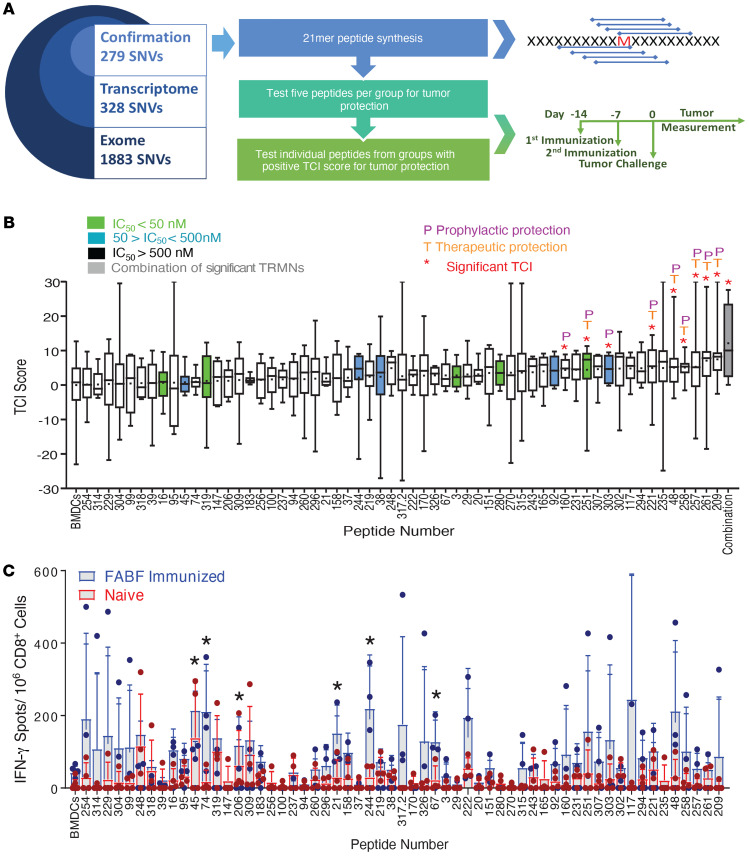
Unbiased identification of TRMNs.(A) All experimentally confirmed SNVs of the MC38-FABF tumor, and screening strategy for tumor rejection. (B) Box-and-whisker plot representing the tumor control index (TCI) scores (9) for 58 of all 279 peptides, represented by numbers on the x axis. The remaining 221 peptides elicited no tumor control and are not shown. The negative control (extreme left) consists of mice immunized with unpulsed BMDCs. Peptides that elicited significant tumor control are marked by asterisks. P and T indicate activity in prophylaxis and therapy. Combination of 9 positive peptides (TRMNs) is on the extreme right. The IC50 values for peptide–MHC I (Kb/Db) were predicted using NetMHC 4.0; the values represent the highest predicted binder for each SNV or an experimentally verified precise neoepitope. Peptides are color coded by IC50 values as indicated in the box. n = 5–15 mice/group, except for the 9 active peptides (TRMNs), for which n = 20–50 mice per peptide. All peptides were tested at least 3 times; the 9 active peptides (TRMNs) were tested between 4 and 8 times each. (C) CD8+ (IFN-γ ELISpot) responses to peptides from B in MC38-FABF–immunized (blue bars) or naive mice (red bars) (n = 4 mice/group). To generate the box-and-whisker plots, data from every single mouse were entered. The box extends from the 25th to 75th percentiles, the middle line represents the median in each group, and the “+” represents the mean. The whiskers extend from the minimum to maximum value. Statistical analysis was conducted for peptides’ response against wells with no target. All peptides were tested at least 2 times. (B and C) Mean ± SD shown. *P < 0.05 by Student’s t test (B) or 2-way ANOVA (C).